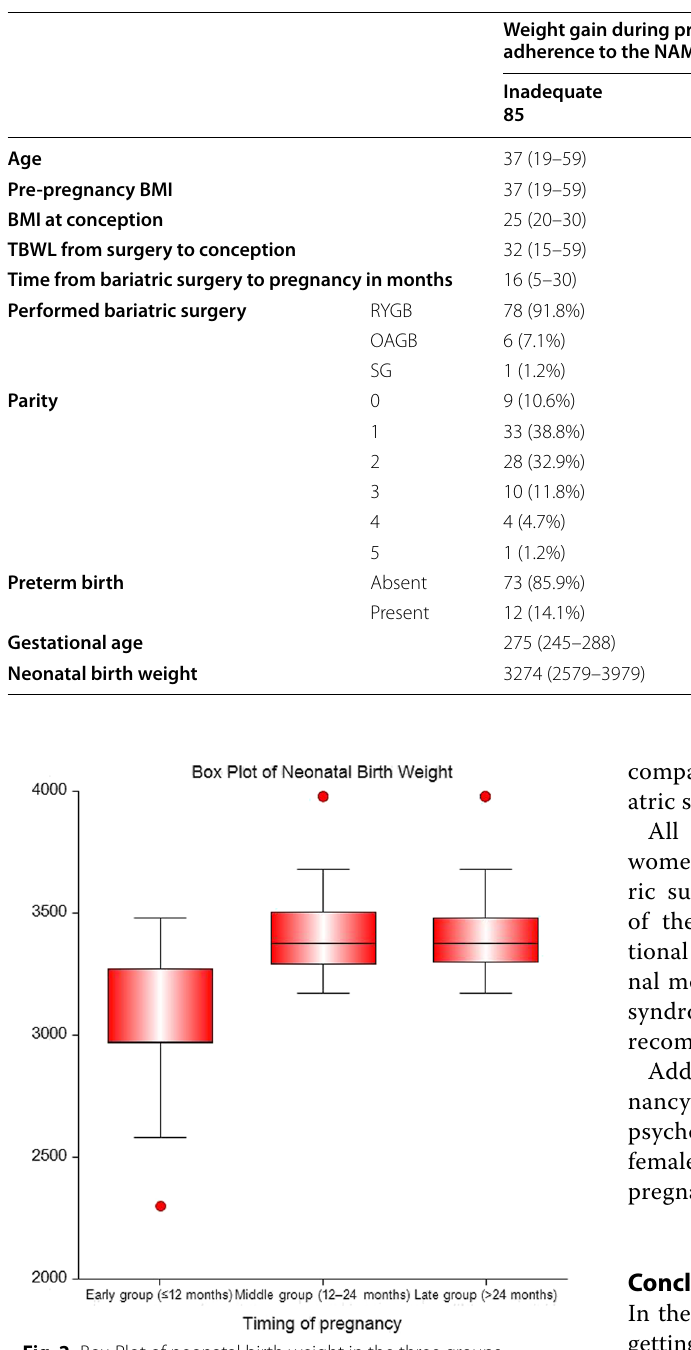
Table 3 Pre‑pregnancy characteristics and pregnancy and neonatal outcomes according to adherence to the NAM recommendations for gestational weight gain